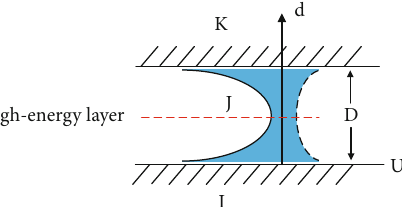
Figure 13: Potential energy distribution in water fi lms on two solid